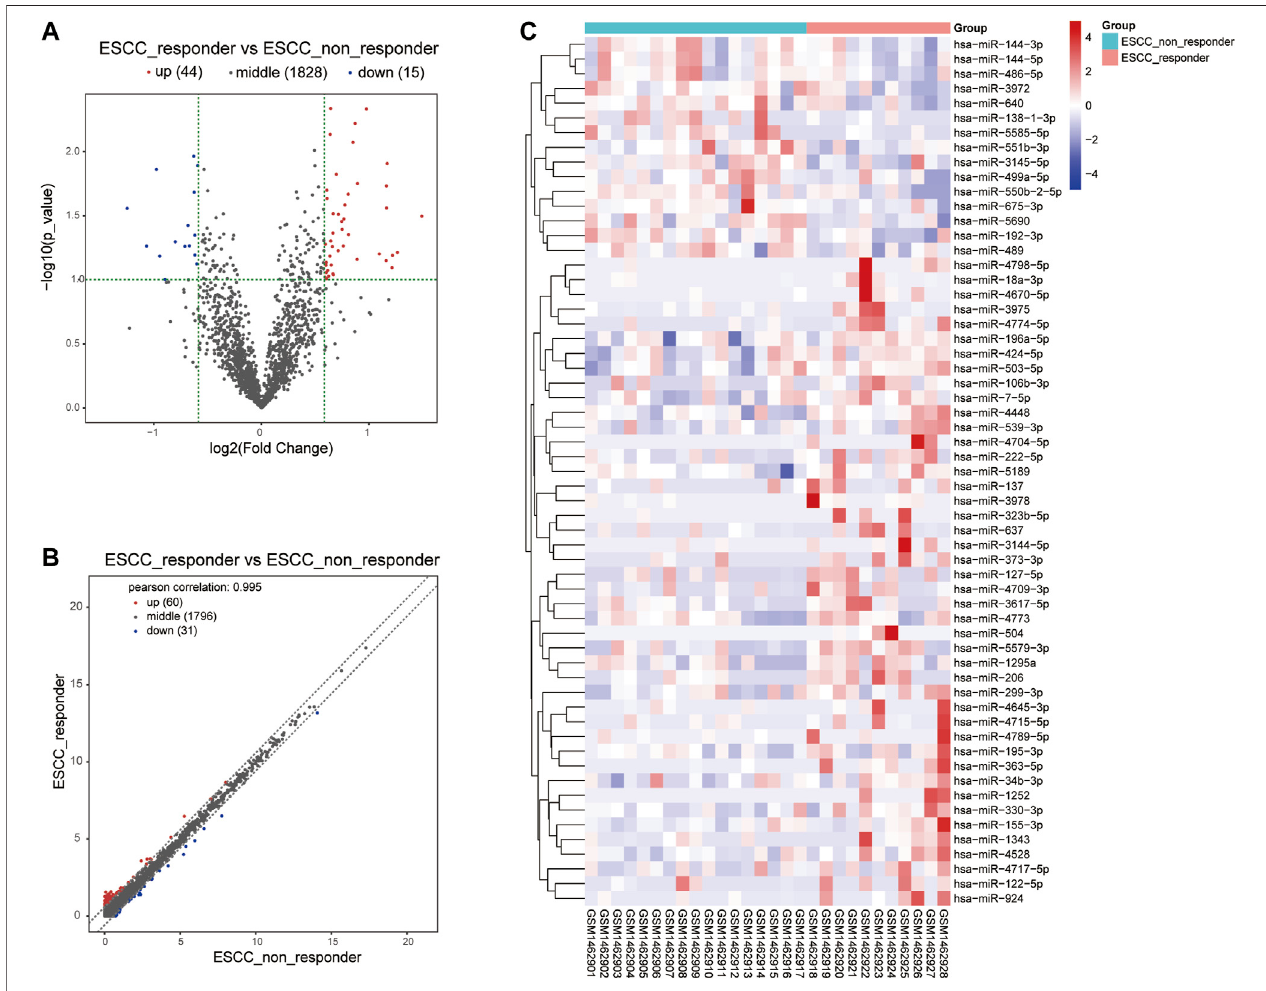
FIGURE3| VolcanoplotandheatmapvisualizedthedifferentiallyexpressedmiRNAscreeningbetweennCRTrespondersandnon-responders. (A,B) Scatterplot and Volcano plot represented the differentially expressed miRNAs found by correlation analysis of ESCC samples. (C) Clustering analysis of differentially expressed miRNAs between nCRT responder and non-responder samples. The color changed from blue to red represented the expression level from low to high.